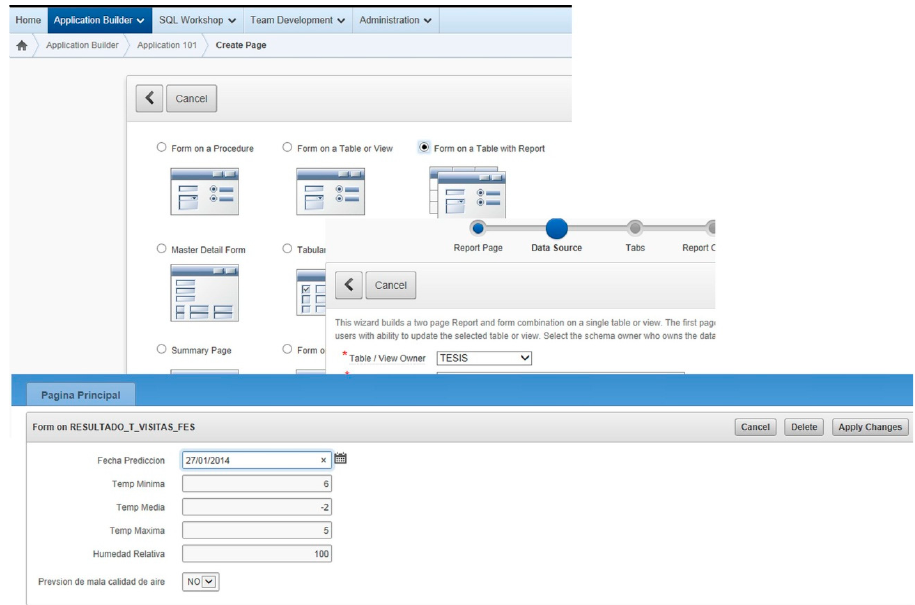
Figure 7. Assistant to develop web